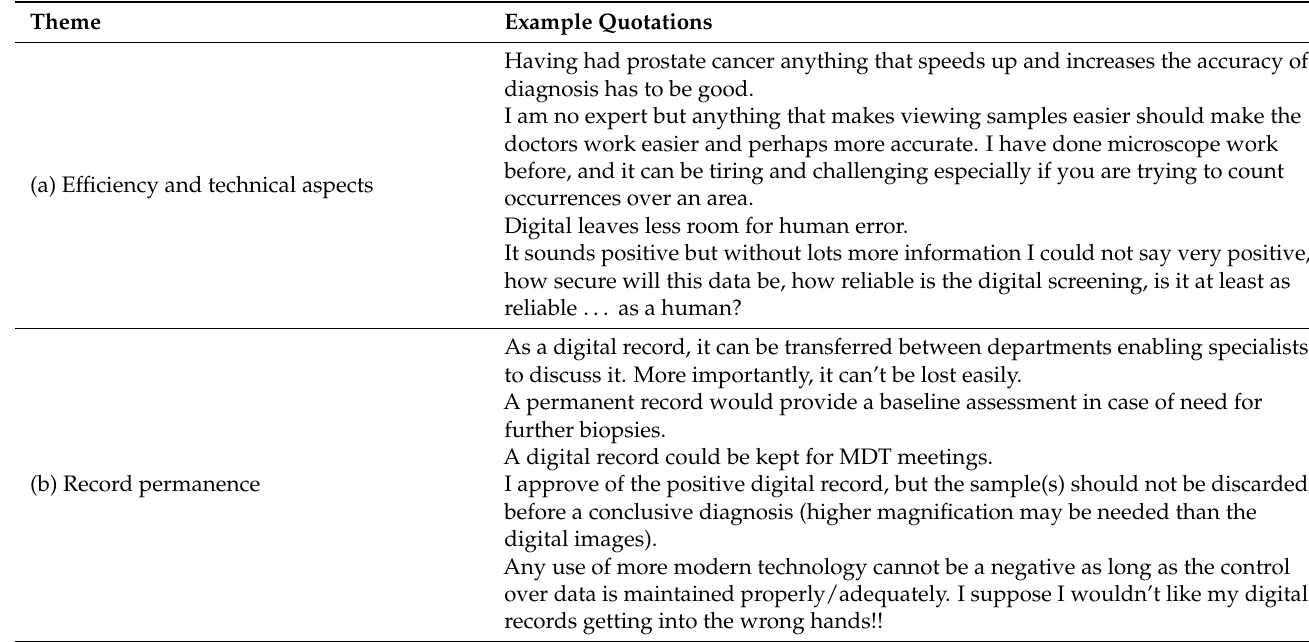
Figure 2. Responses to the question “Some histopathology departments are now going ‘digital’. Slides containing prostate biopsy tissue can now be scanned and viewed digitally on a screen rather than through a microscope. This makes a permanent digital record of the biopsy which reduces the chances of any issues with viewing slides. This also allows histopathologists to easily get a second opinion on a diagnosis. Do you see this change in diagnosing prostate cancer as a positive or negative?” (Please see online supplementary material, Question S7). Table 1. Example free text quotations from respondents on their views regarding the introduction of DP into routine practice.